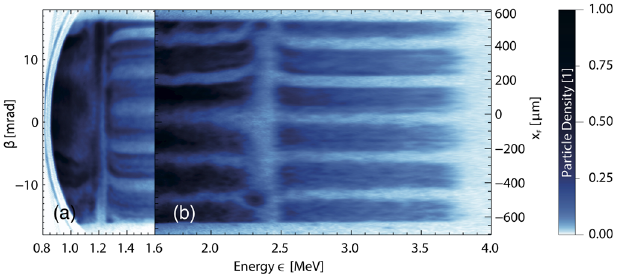
FIG. 9. Comparison between long-pulse-induced (a) and short-pulse-induced (b) streak